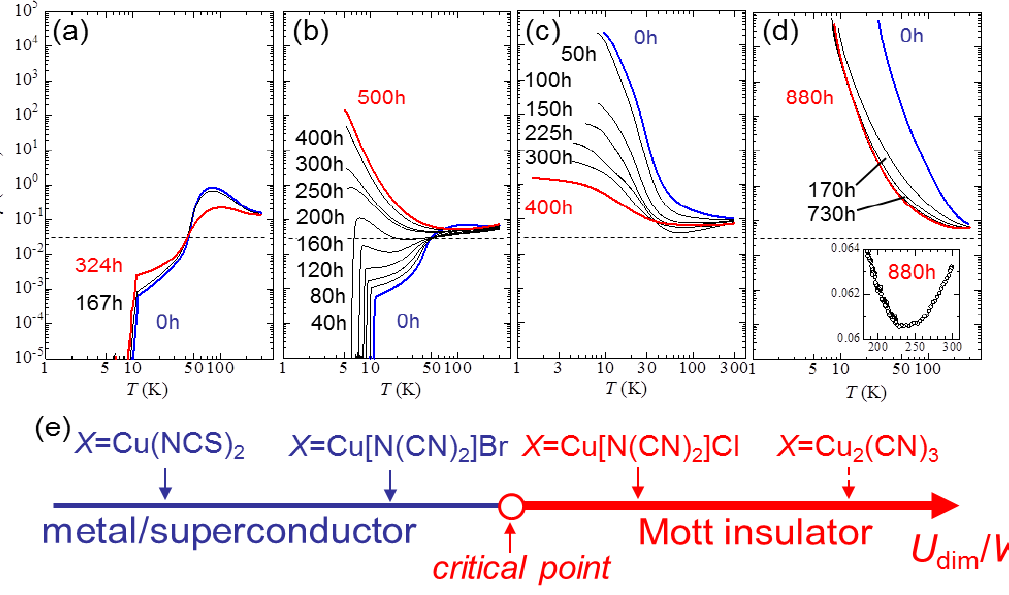
X , ( a ) X = Cu(NCS) 2 ]Cl and ( d ) Cu (CN) irradiated by X-ray. The time 2 2 3 X for U / W 2 dim